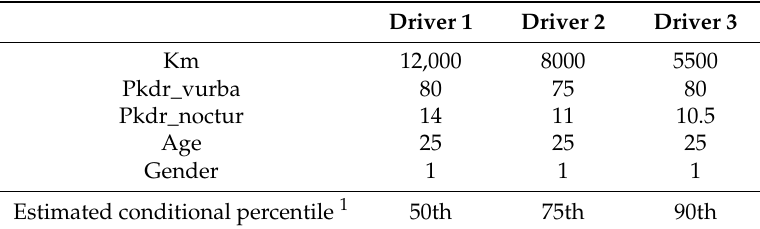
Table 5. Estimates of the conditional percentiles for drivers with di ff erent characteristics, each of whom has driven 600 km above the posted speed